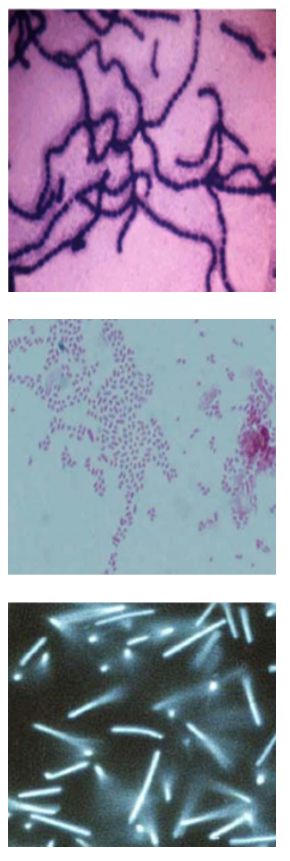
Figure 2. Three Main Categories of Anaerobic Bacteria in the ABR System (a) Hydrolytic Bacteria, (b) Acetogenic